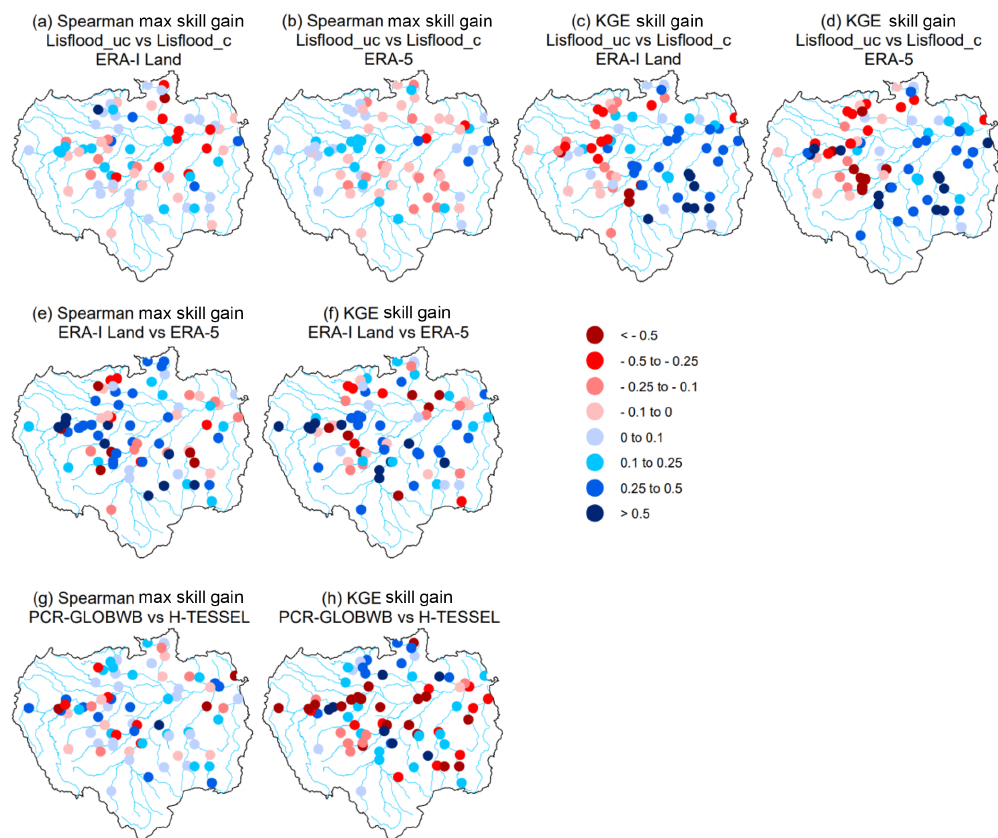
Figure 9. Relative improvement in skill at each gauging station for Spearman annual maximum correlations and KGE values (i.e. skill scores). (a–d) show relative gain or loss in skill when using the calibrated Lisflood run (Lisflood_c) relative to the uncalibrated model run (Lisflood_uc), using precipitation forcing from both ERA-Interim Land and ERA-5. (e) and (f) show the relative gain or loss in skill when using ERA-5 as opposed to ERA-Interim Land. (g) and (h) show the relative gain or loss in skill when using the land surface model (LSM), the Hydrology-Tiled ECMWF Scheme for Surface Exchanges over Land (H-TESSEL), compared to the hydrological model, PCRaster Global Water Balance (PCR-GLOBWB). All scores are calculated using the skill scores in Eq. (1). Red circles indicate a decrease in skill, whereas blue circles represent an